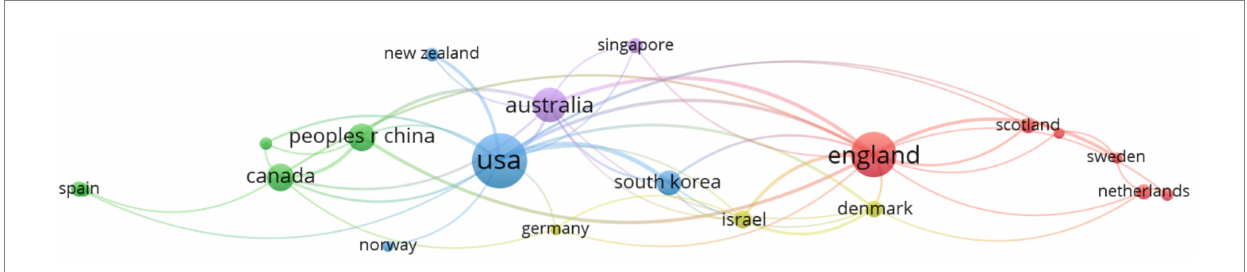
FIGURE 3 Country co-authorship (minimum five